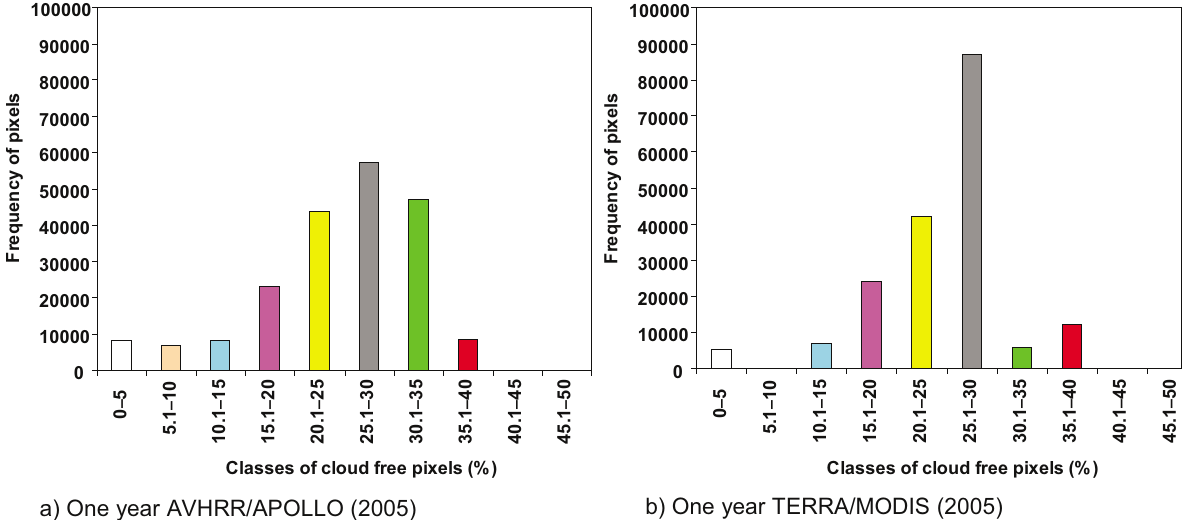
Fig. 4. One year histogram of (a) AVHRR/APOLLO and (b) TERRA/MODIS image classes of cloud-free areas in the